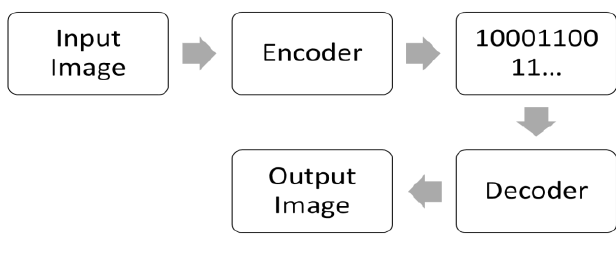
Figure 1. Image Compression